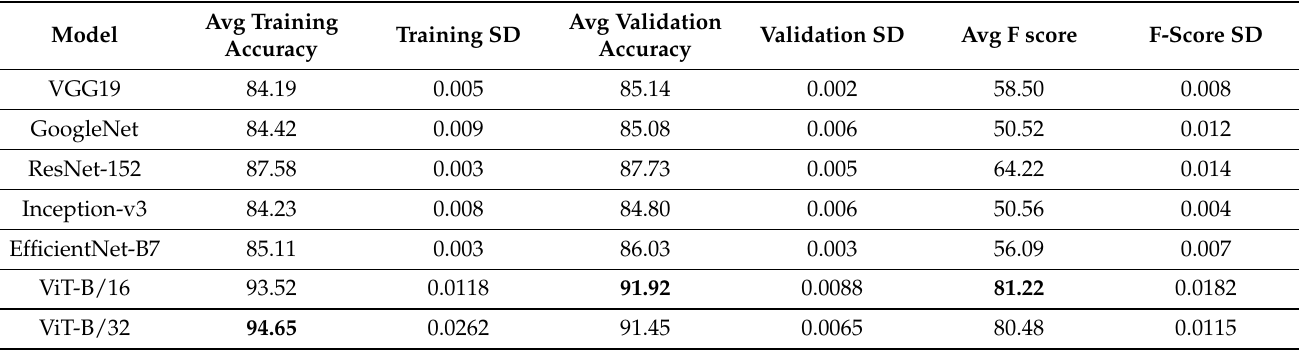
Table 3. Multi-label classification results for road weather detection using simple binary cross entropy loss function (best performance in bold).